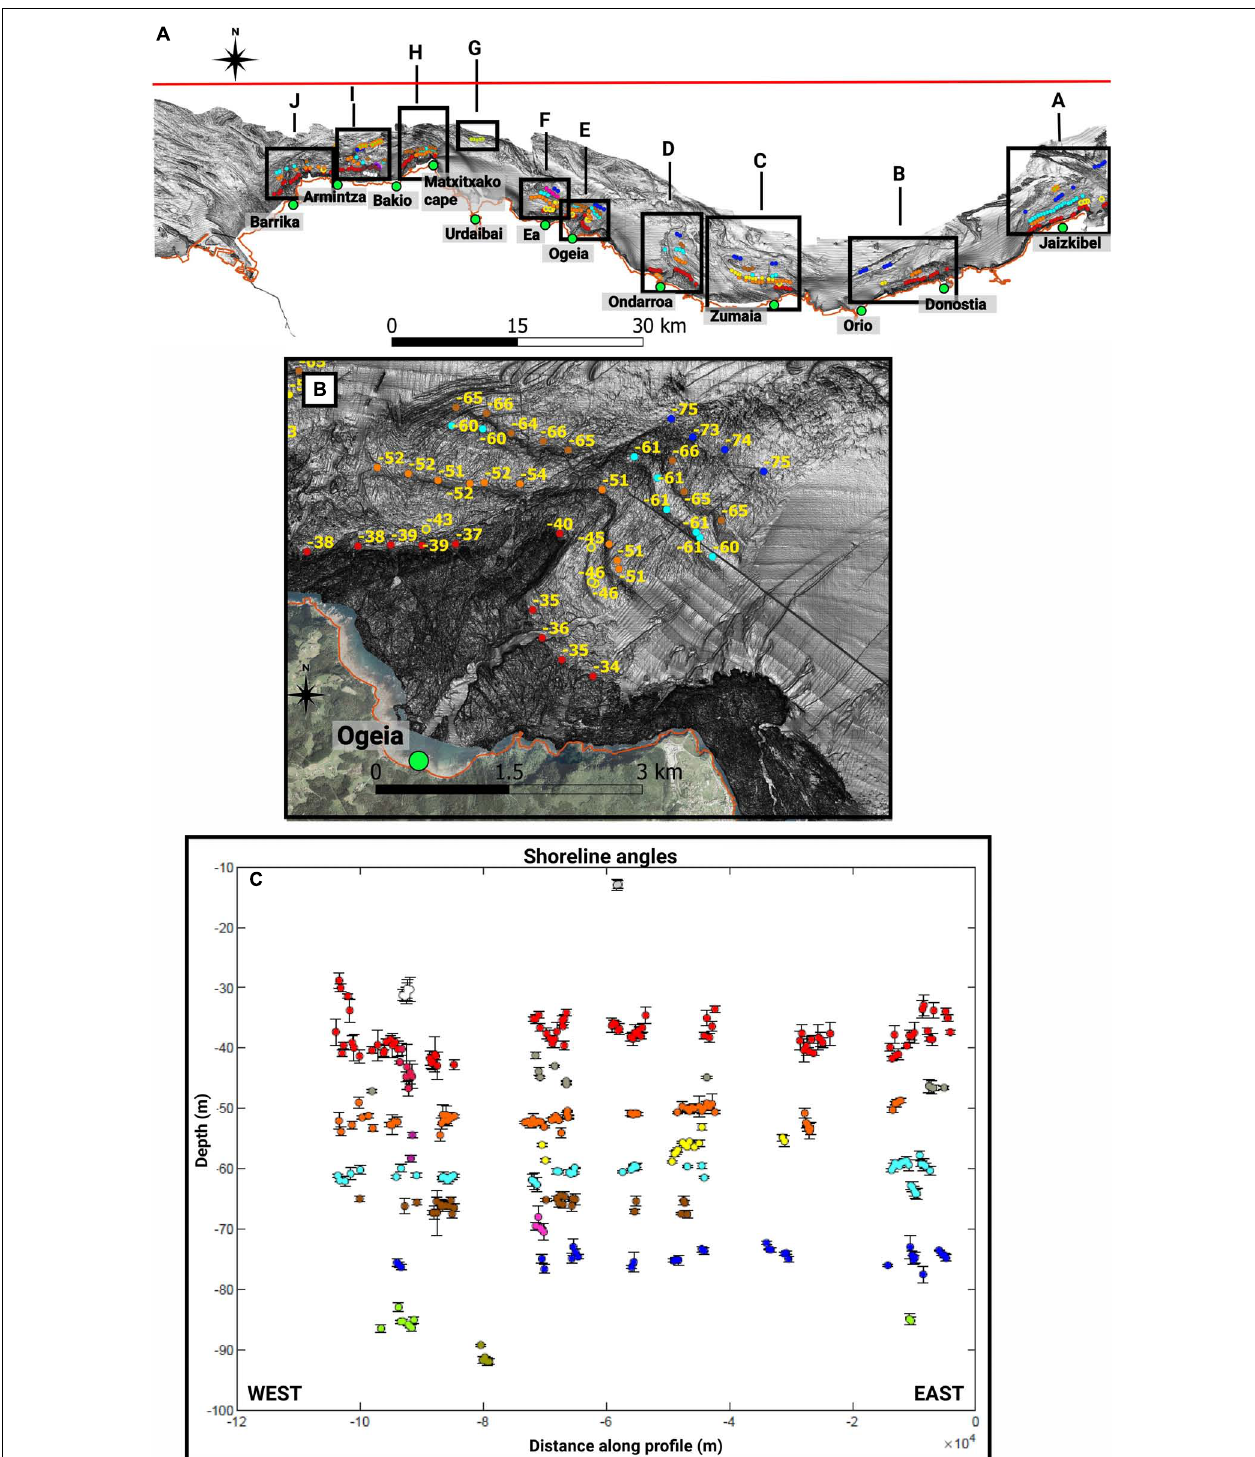
FIGURE 5 | Shoreline angle distribution in the study area. (A) General distribution of submerged marine terraces, with detected shoreline angles in circles. The red line corresponds to the profile along which the shoreline angles are represented on (C) . (B) Amplified segment in front of Ogeia (box E). Circles represent shoreline angles and the numbers their depths. Dotted blue lines represent submerged channels. (C) Shoreline angles along the profile. From top to bottom: Light gray, T1; White, T2; Red, T3; Garnet, Mix between T3 and T4; Dark gray, T4; Orange, T5; Violet, not assigned terrace level, as its depth notably increases to the south. Yellow, T6; Light blue, T7; Brown, T8; Pink, T9; Dark blue, T10; Light green, T11; Dark green, T12.